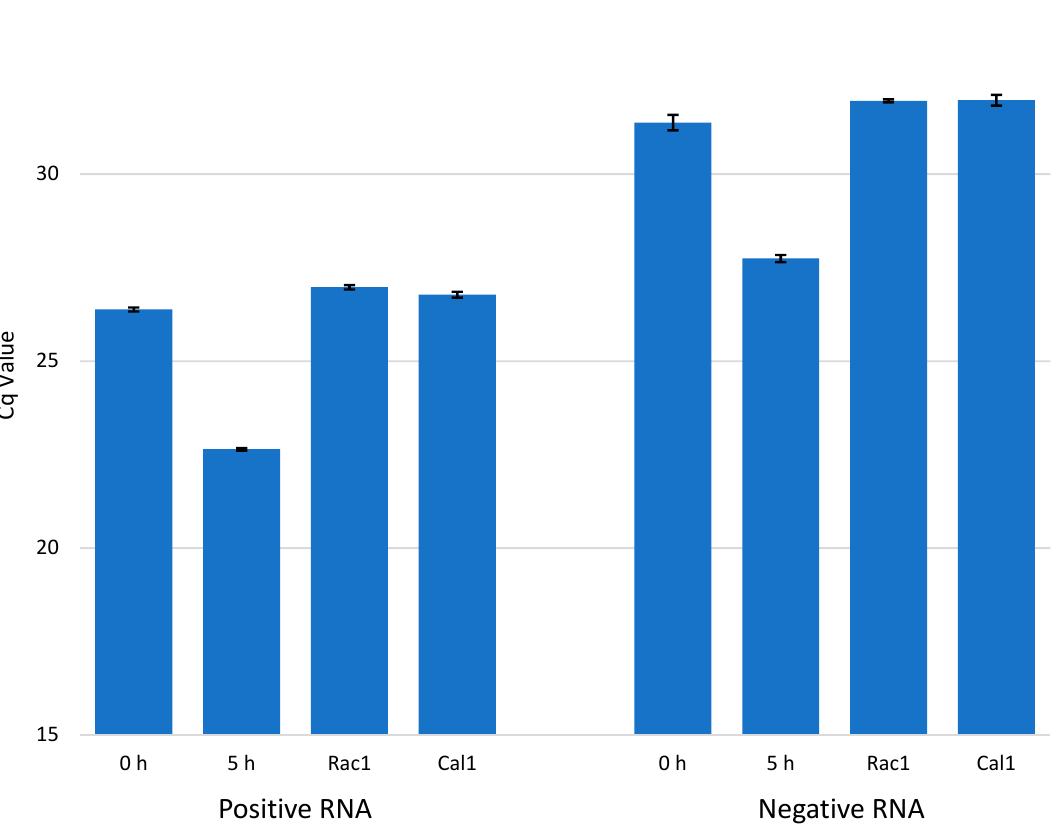
Figure 7. The e ff ect of antiviral drugs Rac1 inhibitor NSC23766 (Rac1-I) and calpain inhibitor 1 (Cal-I1) on the amounts of enterovirus + RNA and − RNA in CVA9-infected cells at 5 h p.i. The amount of + RNA is shown on the left (samples from left to right: 0 h p.i. with no drugs, 5 h p.i. with no drugs, 5 h p.i with Rac1-I, 5 h p.i. with Cal-I1), and the amount of − RNA is shown on the right with the samples in the same order. The bars are averages calculated from triplicate samples, and the error bars are standard deviations from the average values.